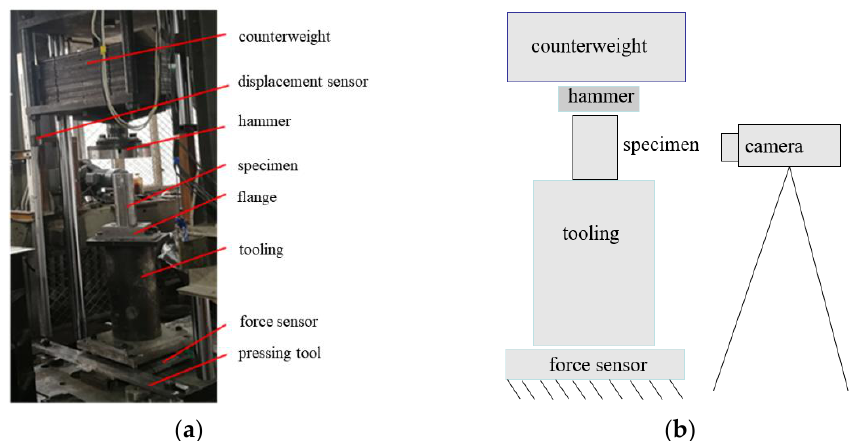
Figure 1. Drop weight impact test. ( a ) Test diagram; ( b ) test schematic diagram.